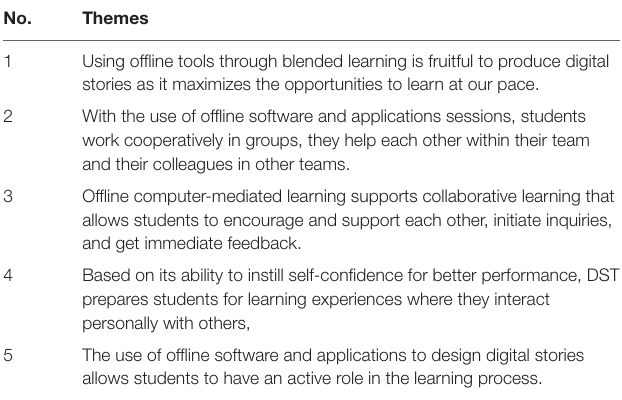
TABLE 4 | Themes of the EAP learners’ attitudes and perceptions toward the impact of online DST on argumentative writing skills, self-directed learning skills, and levels of autonomy in